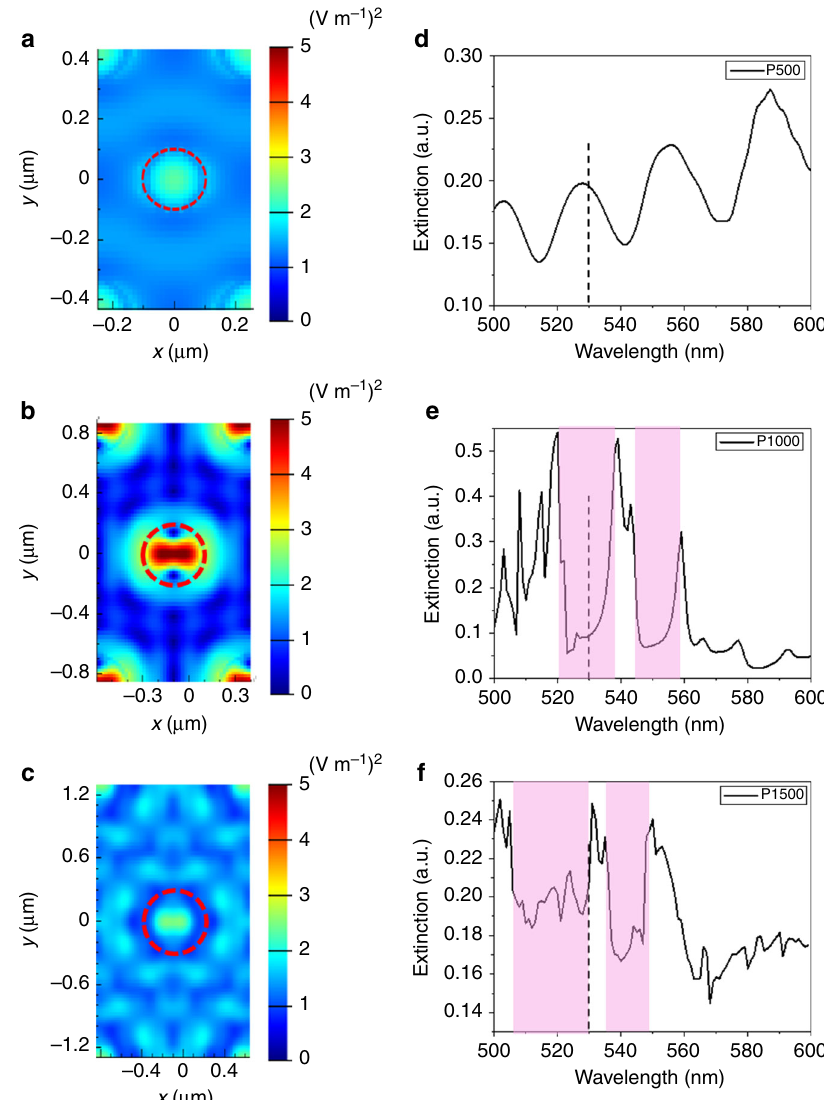
Fig. 6 Near fi eld and extinction (1- transmission) spectra of the photonic crystal optical antennas. Near fi eld of a P500, b P1000 and c P1500 photonic crystals. Extinction of d P500, e P1000 and f P1500 photonic